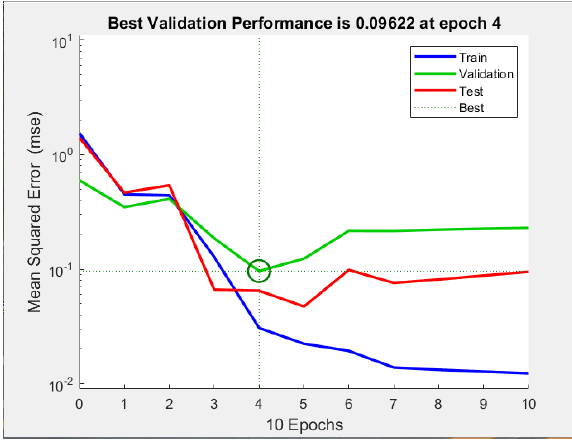
Figure 9. Mean squared error (MSE) versus the number of epochs.